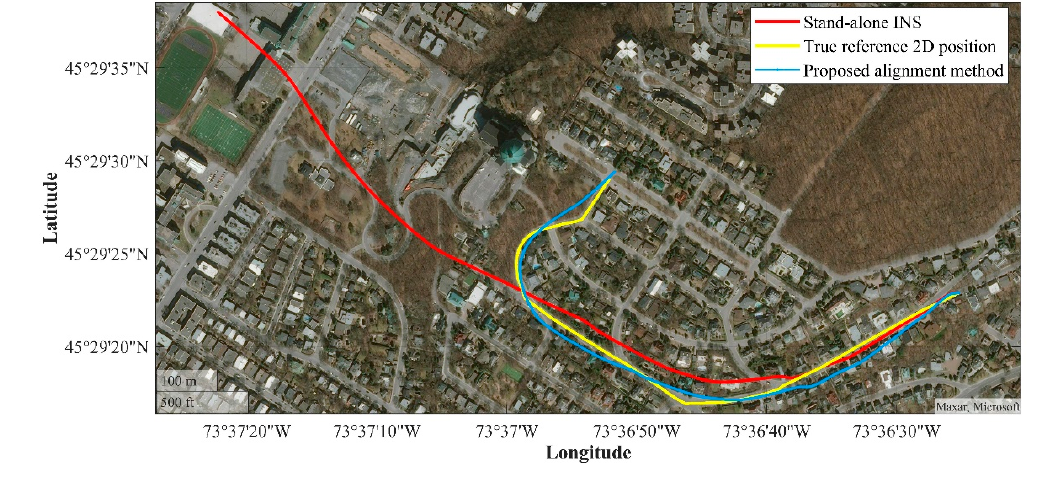
Figure 15. Experimental results include the geographical view of the airport and a comparison of the true and estimated trajectory.